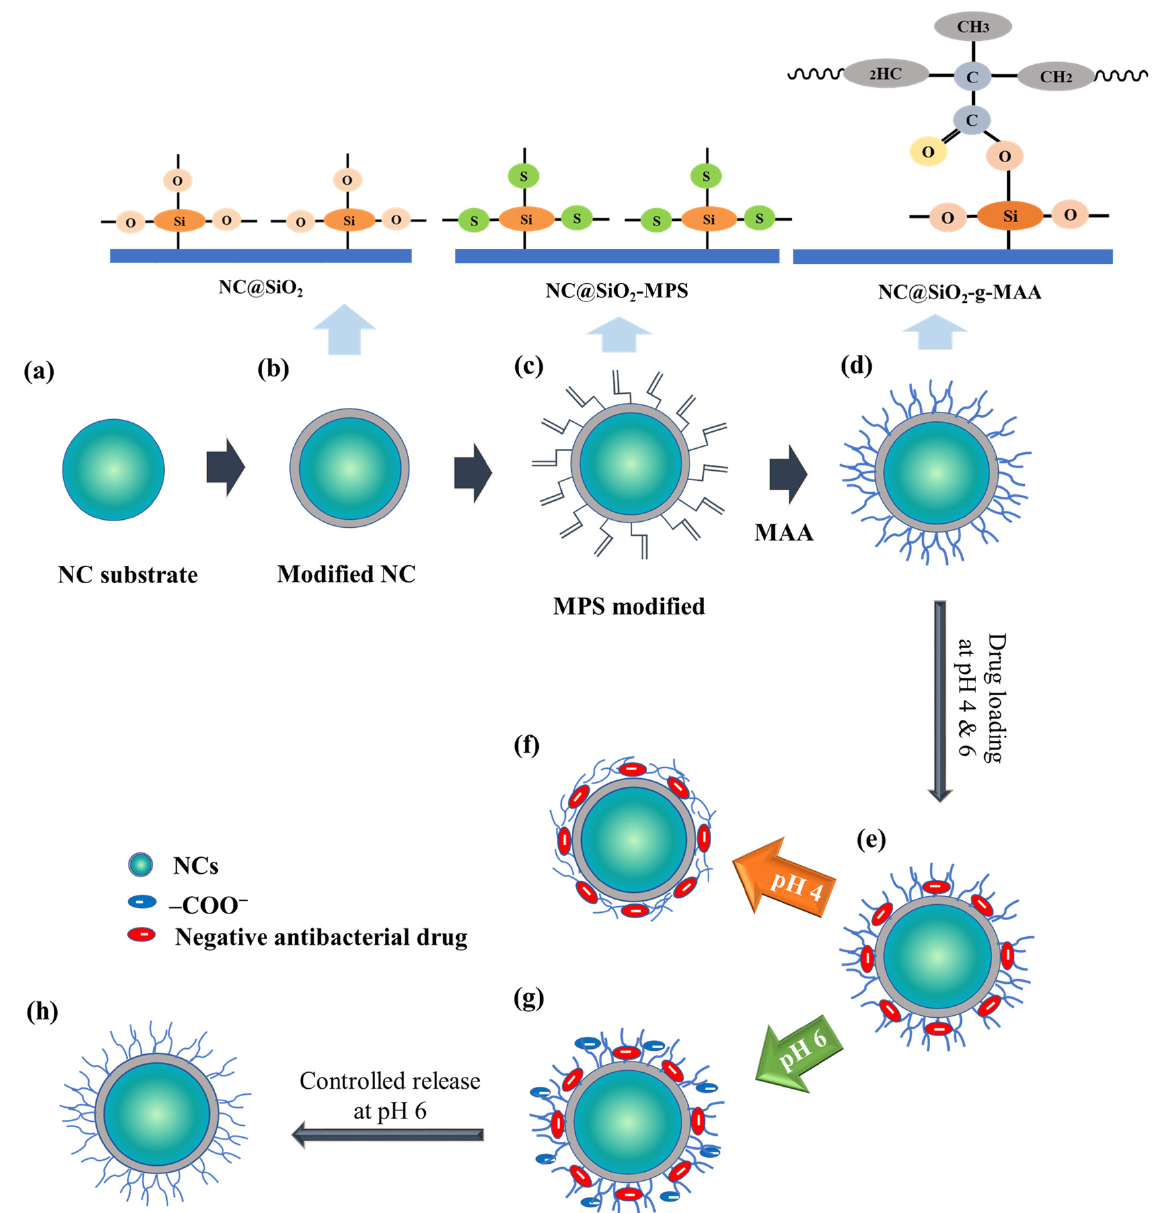
Figure 1. Chemical structure as it was modified to form pH- and humidity-sensitive self-antimicrobial NCs; ( a ) formation of NC substrate, ( b ) TEOS modification, ( c ) surface modification with MPS, ( d ) MAA ligand brushes grafted on the NC surface, ( e ) drug-loaded NC, ( f ) controlled drug release at pH 4, ( g ) controlled drug release at pH 6, and ( h ) pH triggered drug release at pH 6.